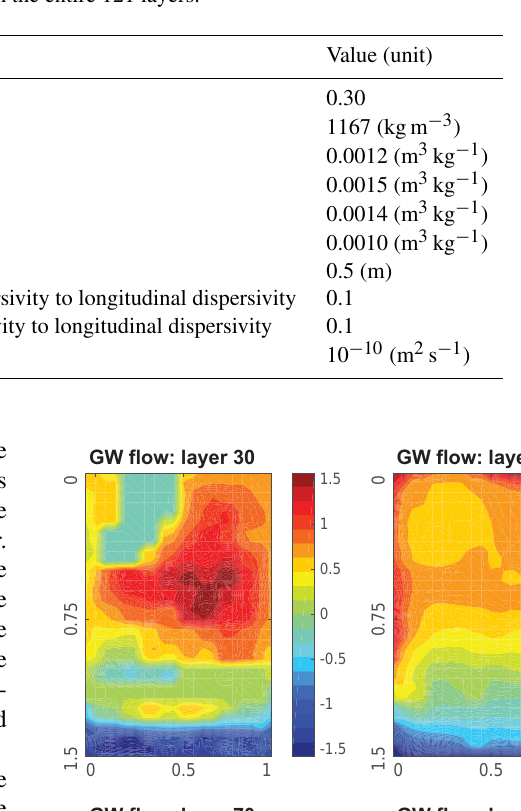
Table 1. Different modeling parameters for the coupled flow–transport–reaction model. The values given for 3-D parametric fields, such as bulk density and distribution coefficients, are the mean values from the entire 121 layers.